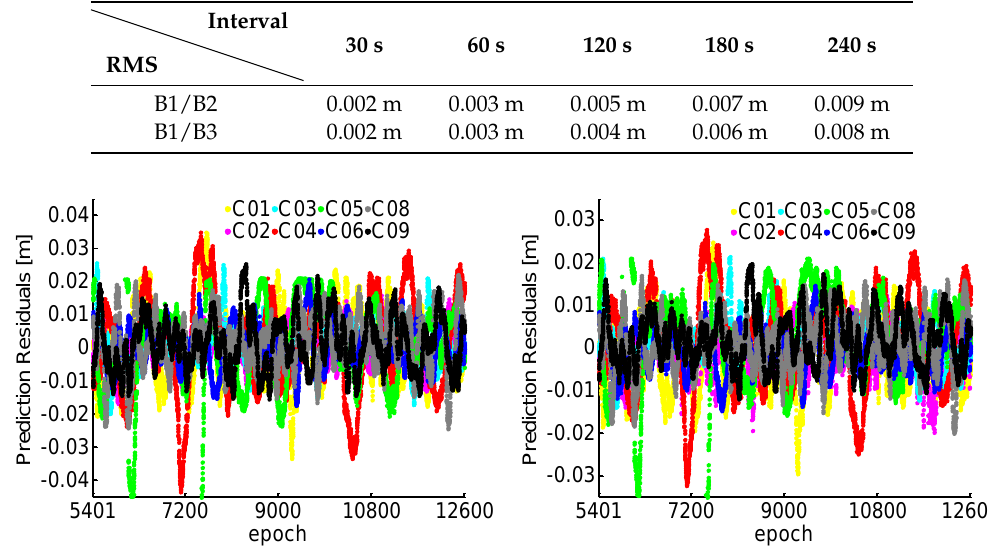
Figure 9. Ionospheric prediction residuals with 240 s intervals. The left panel shows the residuals based on B1 and B2, the right panel based on B1 and B3.